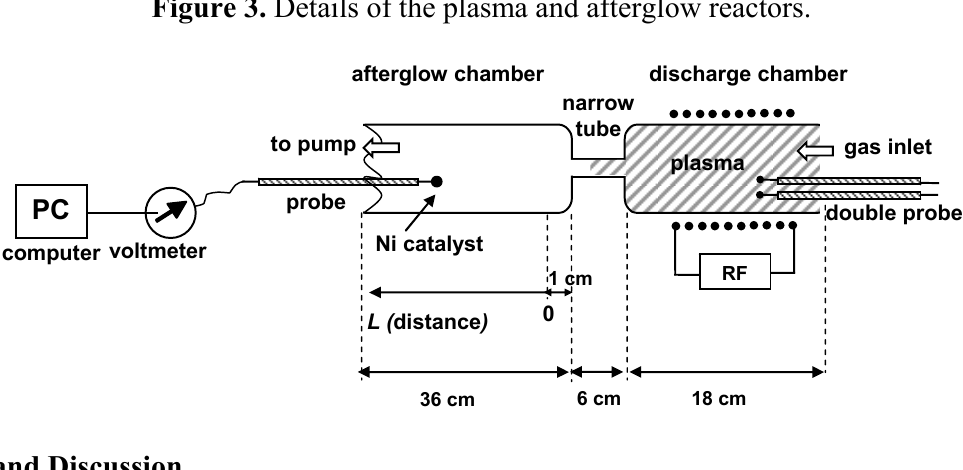
Figure 3. Details of the plasma and afterglow